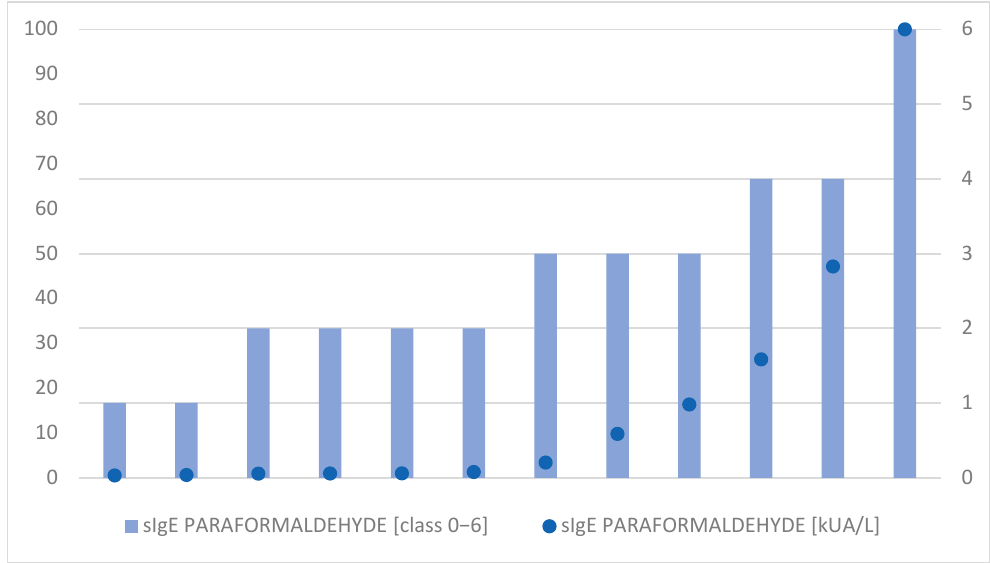
Figure 2. Level of specific IgE against paraformaldehyde.